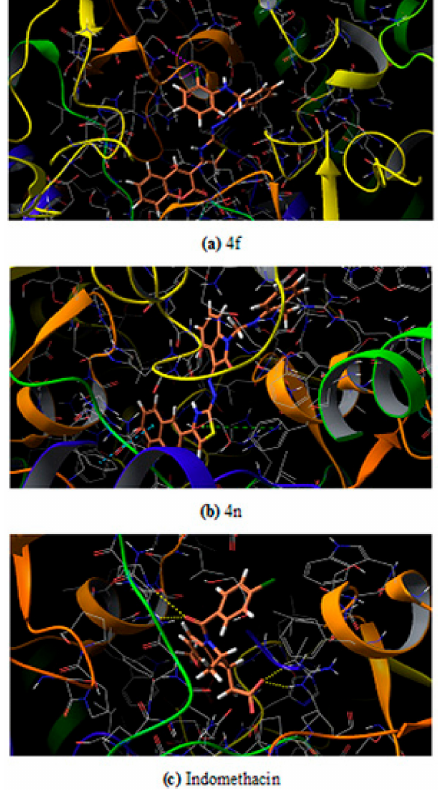
Figure 5. Test ligands and control drug ( a ) 4f , ( b ) 4n , ( c ) Indomethacin, docked inside the binding pocket of COX-2 from a mouse.